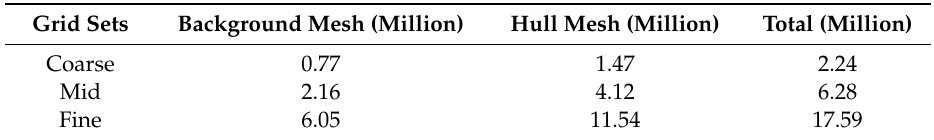
Table 3. Details of the mesh generation.